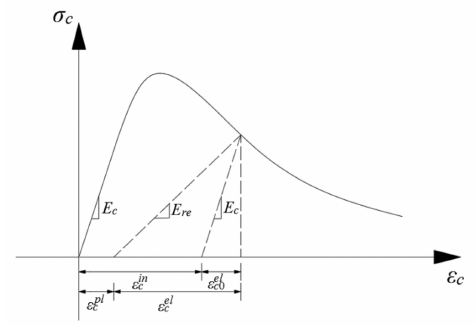
Figure 3. Schematic diagram of the CDP model.